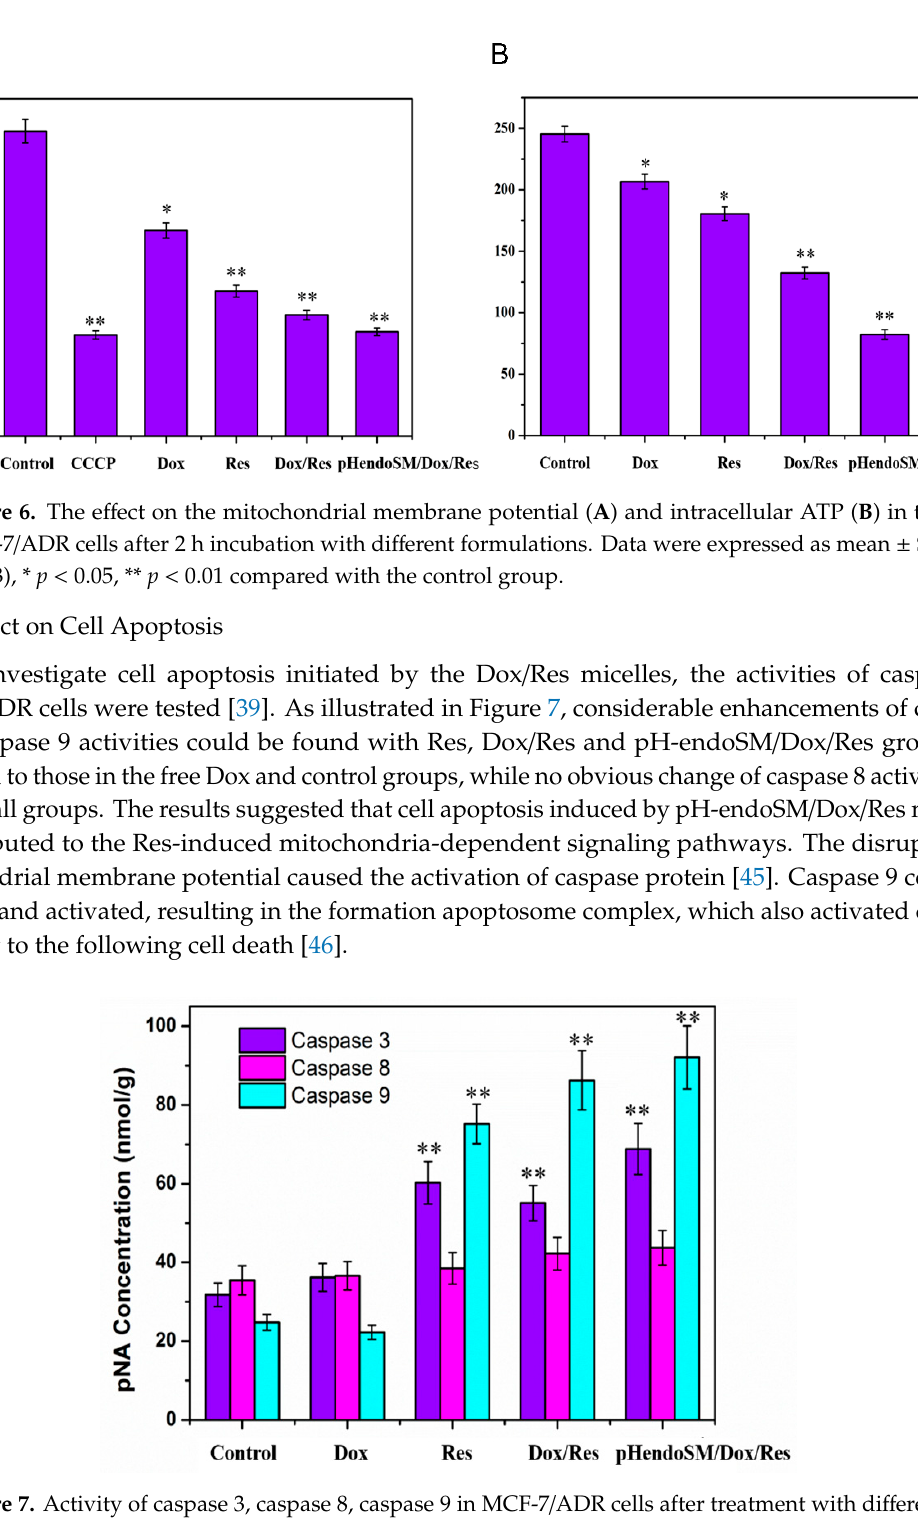
Figure 7. Activity of caspase 3, caspase 8, caspase 9 in MCF-7/ADR cells after treatment with different formulations for 24 h. Data were expressed as mean ± SD (n = 3), * p < 0.05, ** p < 0.01 compared with the control group.